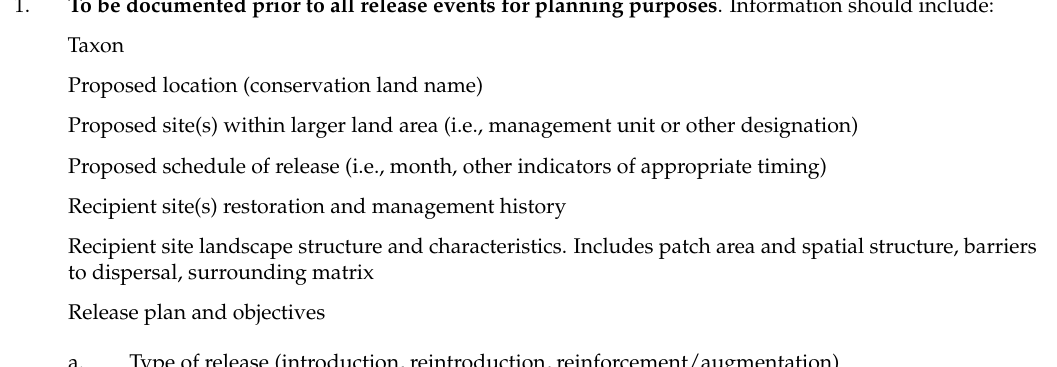
Table 1. List of recommended actions and types of information to be